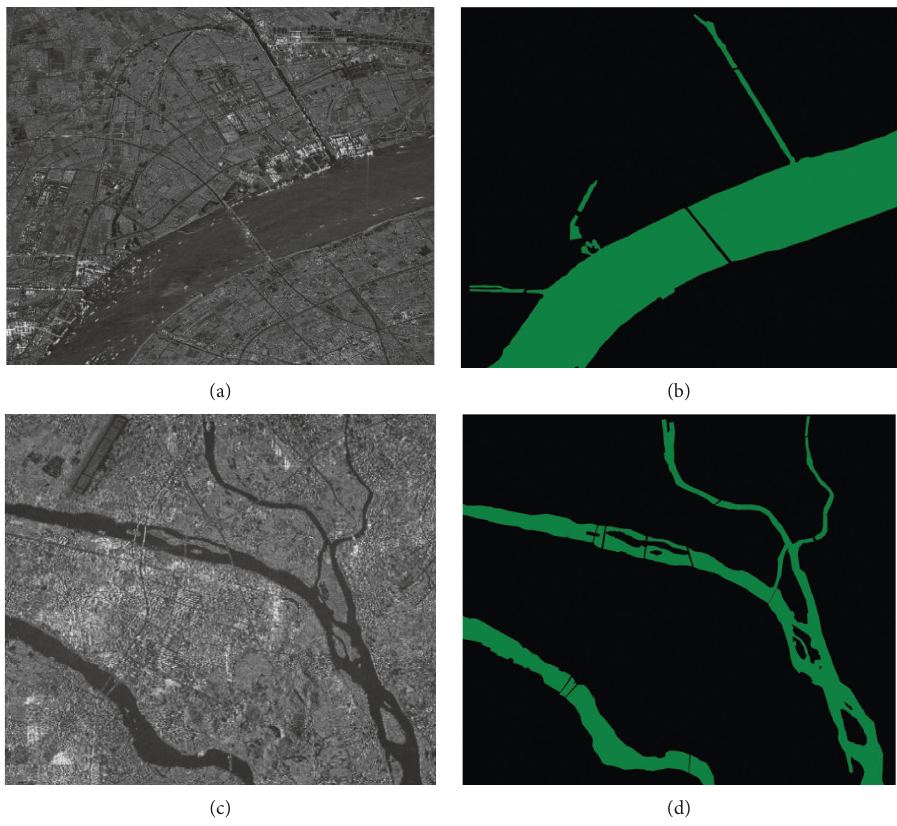
Figure 2: Images and corresponding ground truths in the segmentation